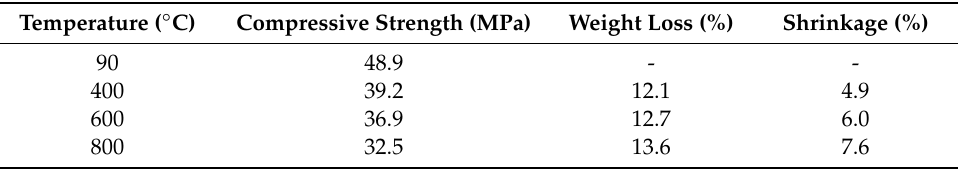
Table 6. Selected properties of B50S50 IPs fired at high temperatures 1 .